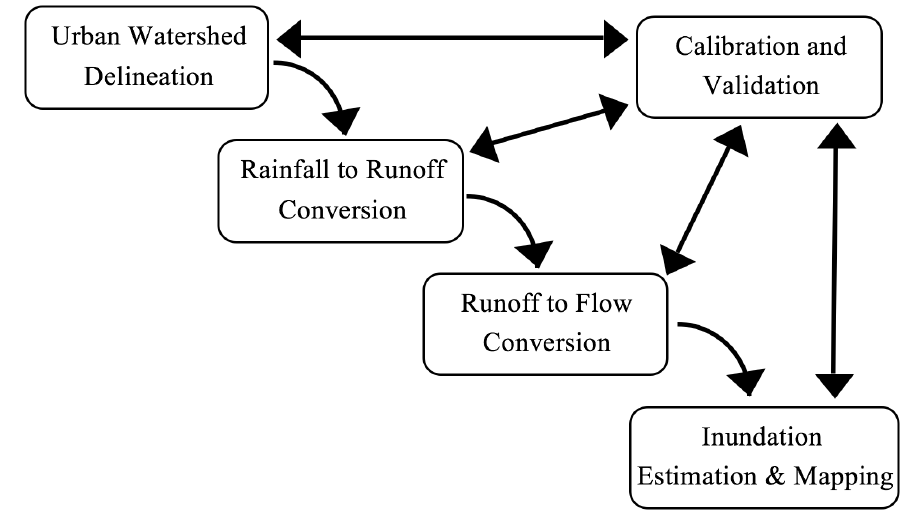
Figure 1. GIS framework for spatiotemporal flood modeling and